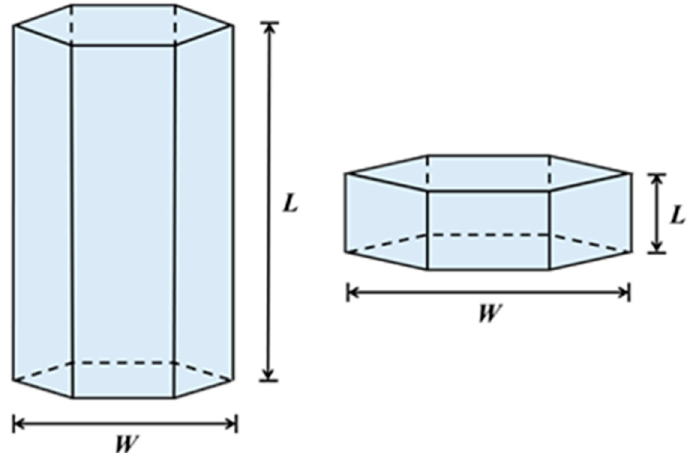
Figure 3. Shapes of hexagonal columns with length ( L ) and width ( W ). Aspect ratio ( AR ) is defined as AR = L / W . The long column ( left ) has a higher AR , while the thin plate ( right ) has a smaller AR . Table 2. Dimensional information of hexagonal ice crystals for a given aspect ratio ( AR ) used in this study. The L , W , and D max is the length, width, and maximum dimension of a hexagonal ice crystal, respectively. A size parameter ( χ Dmax ) is defined as χ Dmax = π D max / λ . AR = 0.25 AR = 0.50